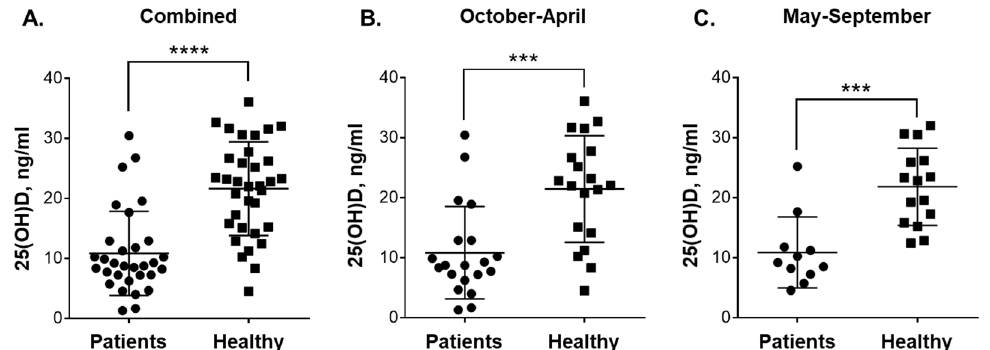
Figure 1. Plasma 25(OH)D levels in blood samples of patients with leukemia and healthy subjects taken during colder and warmer seasons. Comparison between: ( A ) all the participated patients (n = 31) and healthy subjects ( n = 34); ( B ) patients ( n = 20) and healthy subjects ( n = 19) in October-April; and ( C ) patients ( n = 11) and healthy subjects ( n = 15) in May-September. Data are the means (long horizontal lines) ± SD. ***, p < 0.001; ****, p < 0.0001.